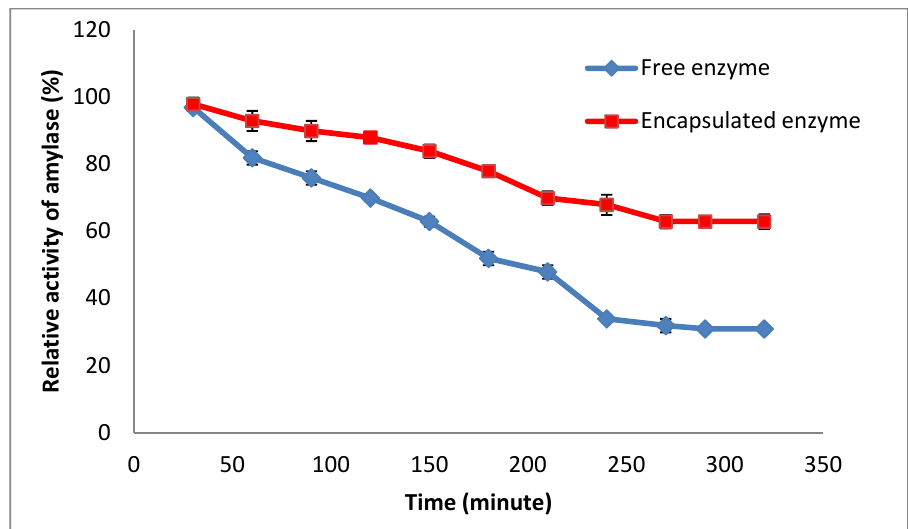
Figure 1. Effect of encapsulation on the amylase